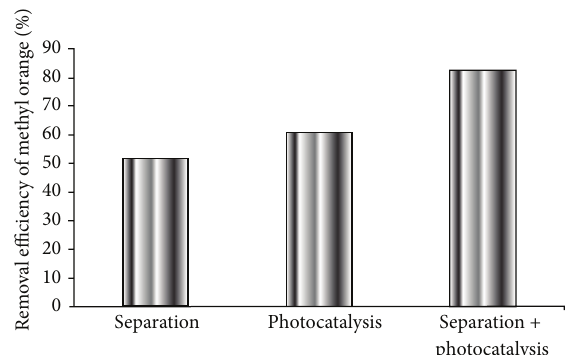
Figure 19: MO removal efficiency in the presence of anatase membrane by the different